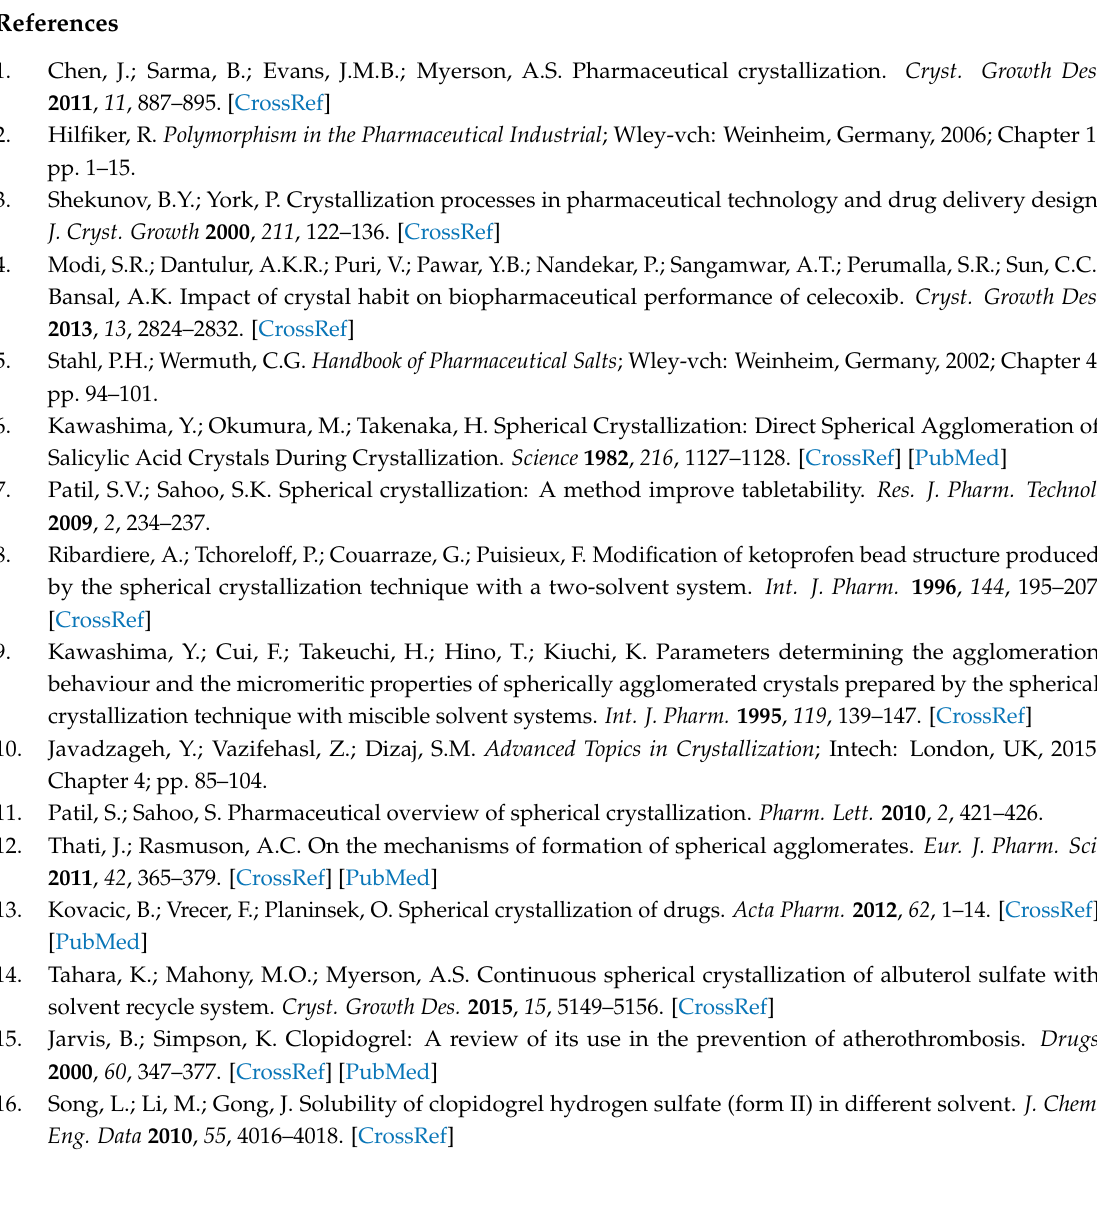
Figure S1: Powder patterns of CLP crystals obtained when IPA/Hex [40:60, v/v] was used as an anti-solvent at a stirring speed of 800 rpm, 700 rpm, 600 rpm, and 500 rpm (from top to bottom). The mixture of Forms-I and -II were obtained at a stirring speed of 800 rpm while, form I was obtained at any other stirring speeds studied; Figure S2: ATR-FTIR spectra of CLP crystals obtained at various temperatures − 40, 35, 30, 25, and 20 ◦ C (from top to bottom). Anti-solvent was IPA/Hex [40:60, v/v], and the stirring speed was set at 500 rpm; Figure S3: FTIR spectra during CLP crystallization at 35 and 40 ◦ C. FTIR spectra suggesting that (a) the polymorphic transformation from Form-I to Form-II occurred within 40 min. at 35 ◦ C, and (b) the polymorphic transformation from Form I to Form-II completed within 60